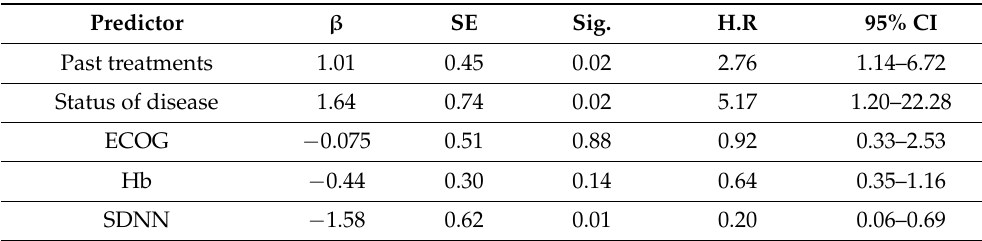
Table 2. Multivariate Cox regression between all significant bivariate predictors and overall survival in